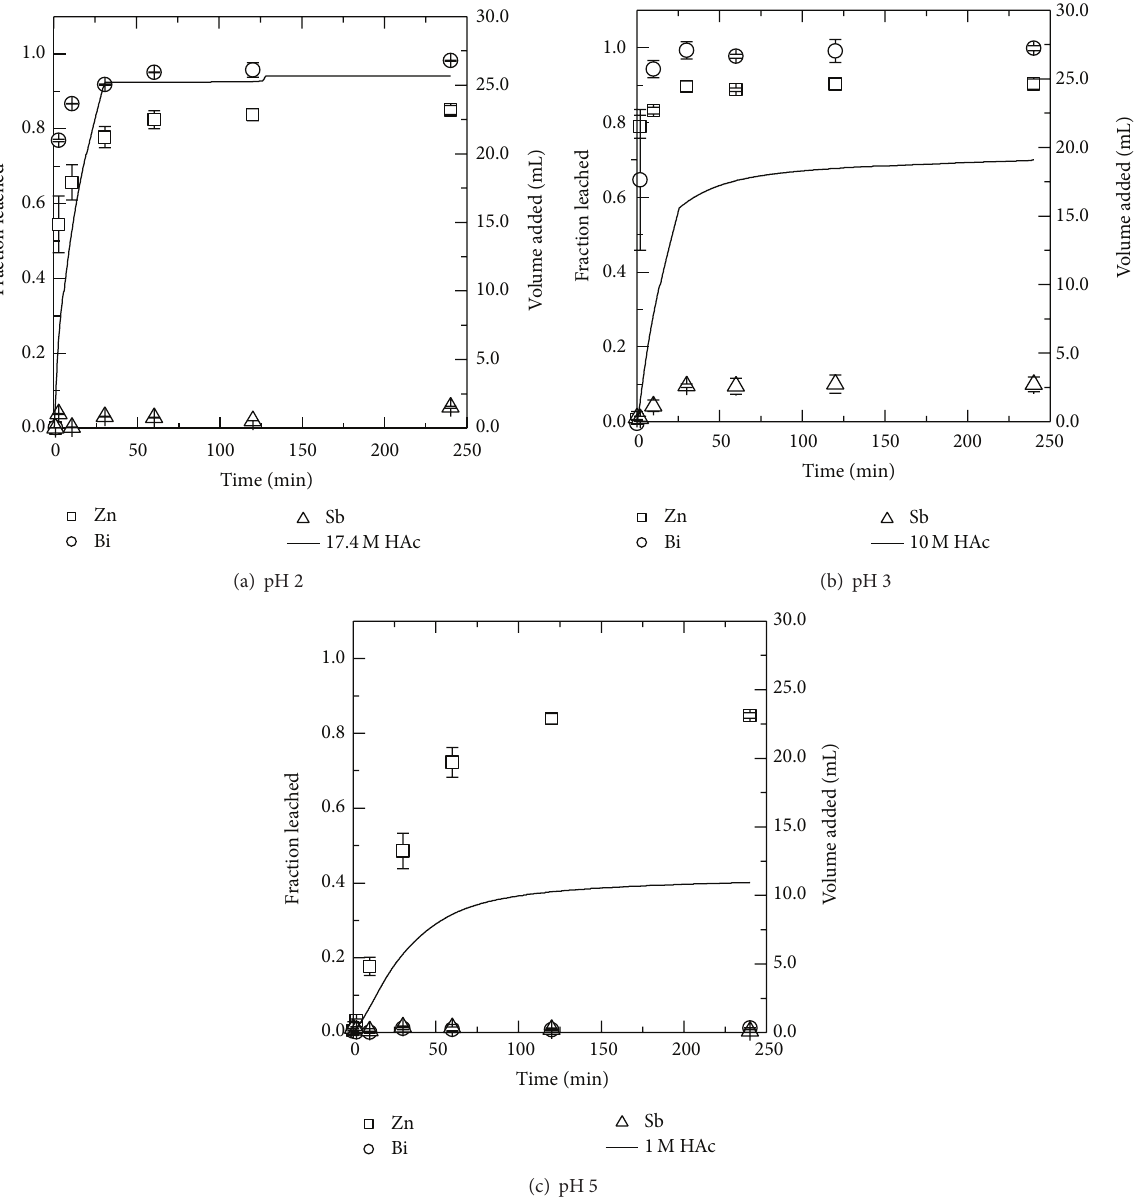
Figure 3: The leached fraction as given by the left ordinate for zinc ( ◻ ), bismuth ( I ), and antimony ( 󳵻 ) from MOV in (a) pH 2, (b) pH 3, and (c) pH 5 solutions. The volume of acetic acid (HAc) added is shown as a solid black line corresponding to the right ordinate.